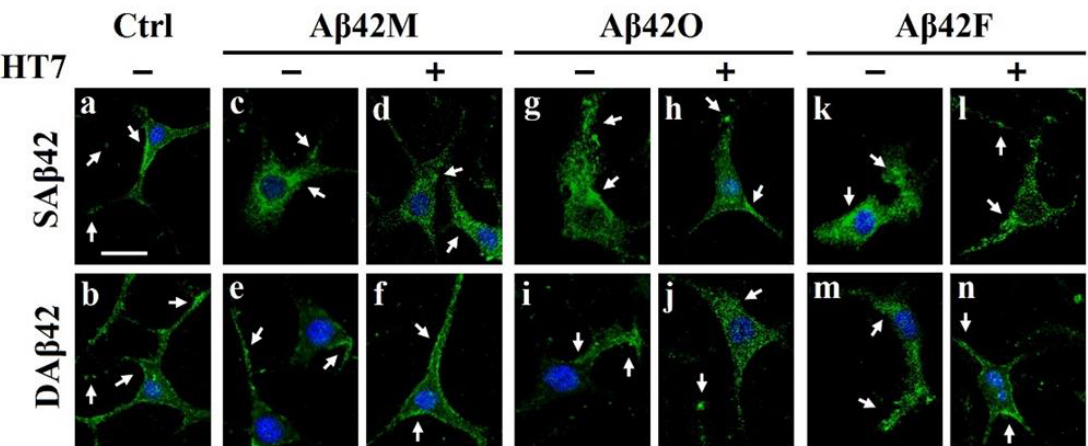
Figure 5. Representative confocal images of immunofluorescence of palladin (green) in differentiated SH-SY5Y cells at 24 h after incubating with three A β 42 species with/without anti-oligomeric A β 42 scFv HT7 antibody. These images represent enlarged partial regions of the representative whole images shown in Figure S2. The merged images show palladin (green) and nucleus (blue). White arrows point to significant localization of palladin. Scale bar = 30 µm.